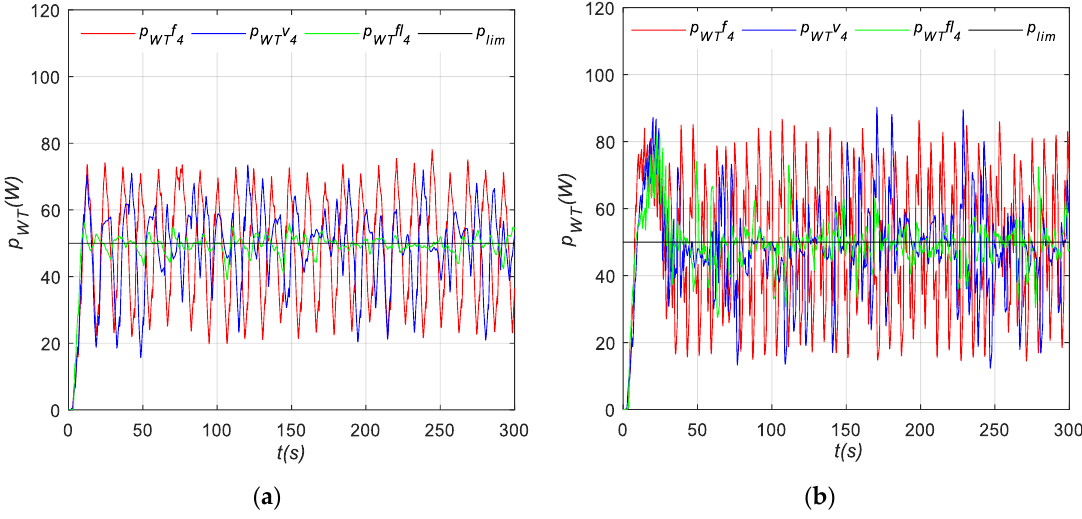
Figure 15. Comparison of experimental results: ( a ) evolution of p WT at LPP1; ( b ) evolution of p WT at LPP2.